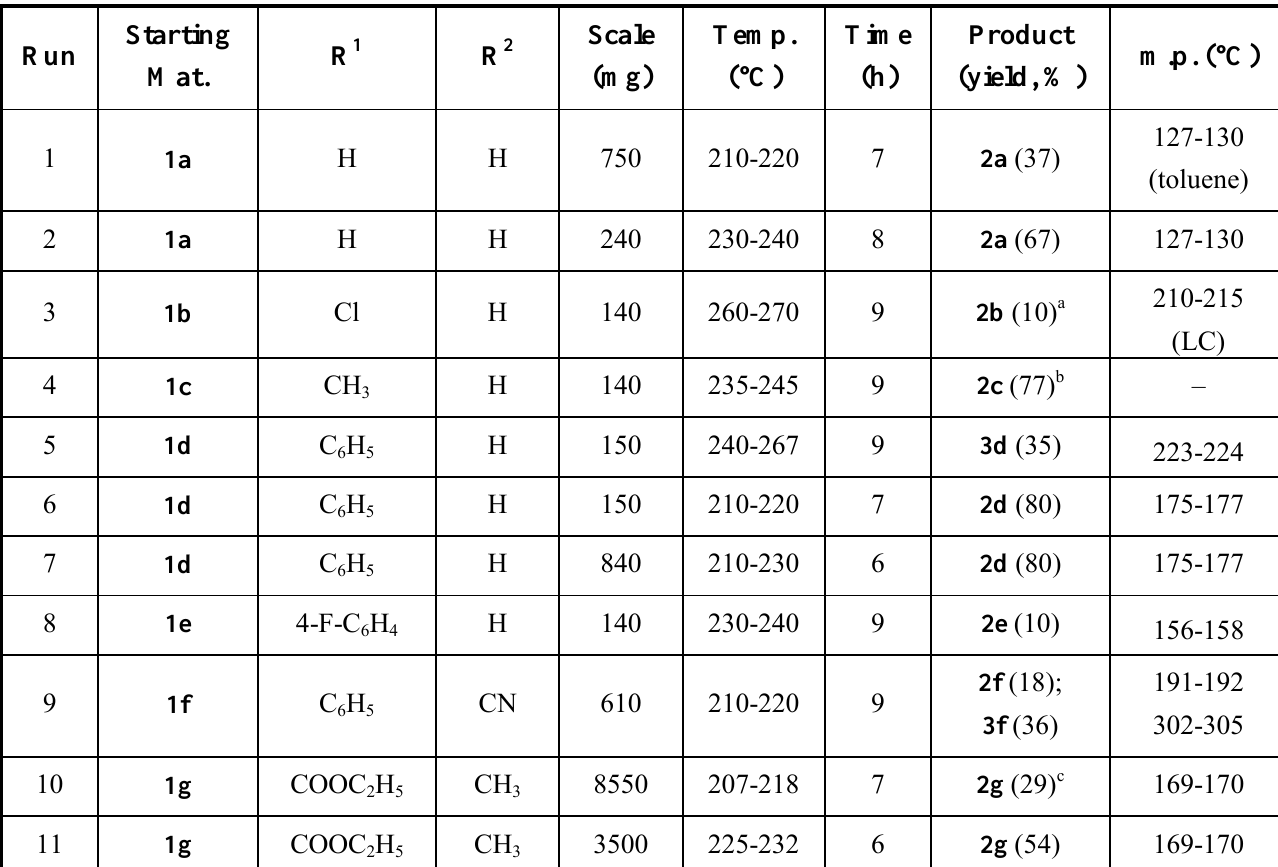
Table 1 : Thermolysis of Thieno[2,3-d]-1,2,3-thiadiazoles